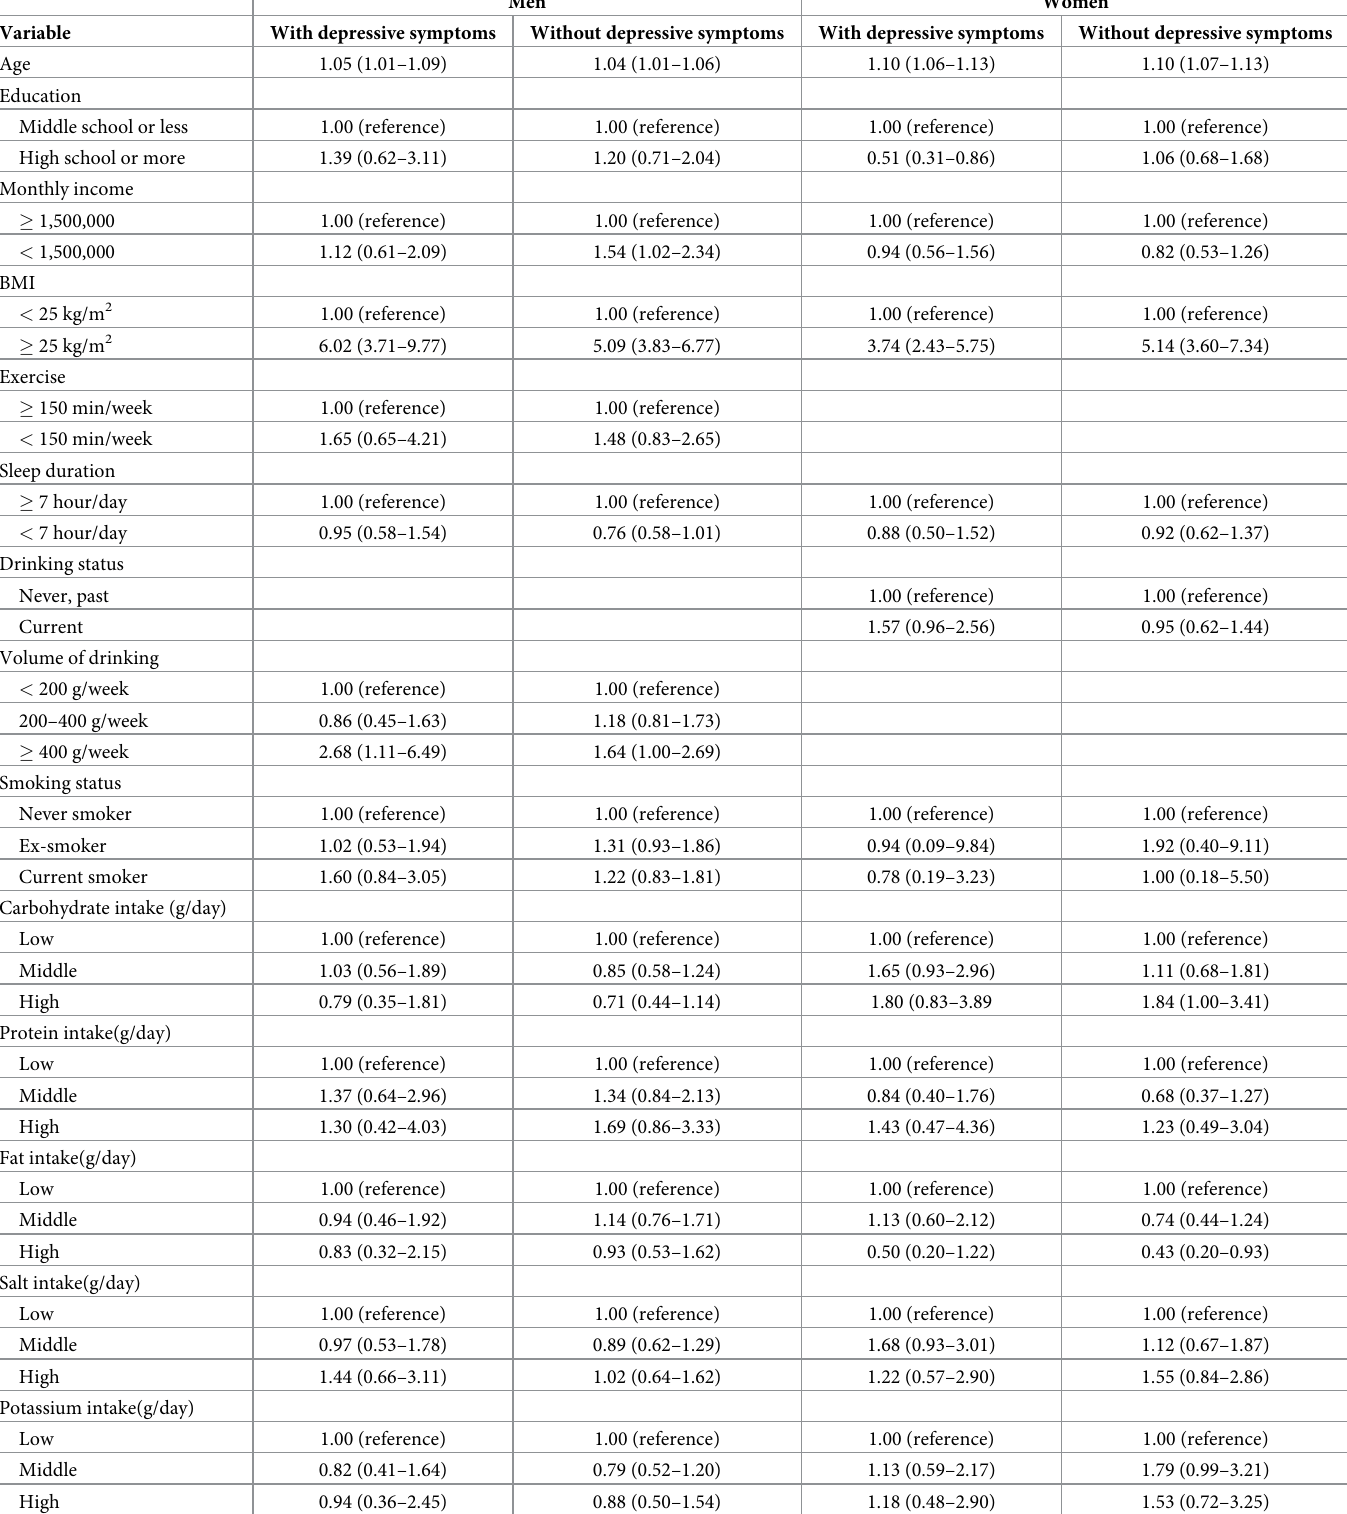
Table 3. Adjusted odds ratios for metabolic syndrome in subjects with and without depressive